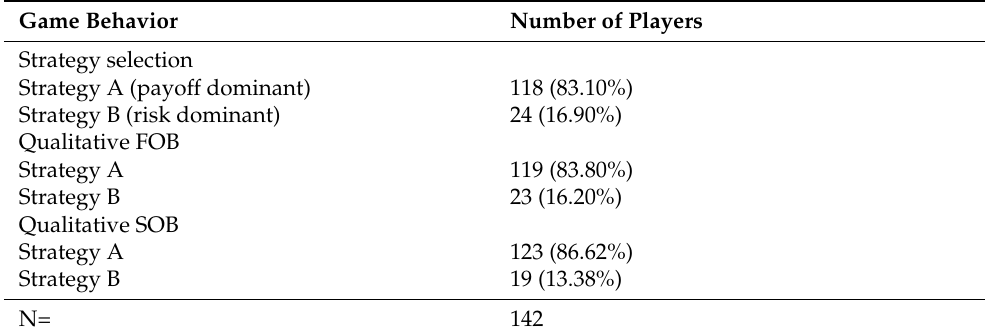
Table 3. Strategy selection, qualitative FOB, and qualitative SOB in the coordination game.